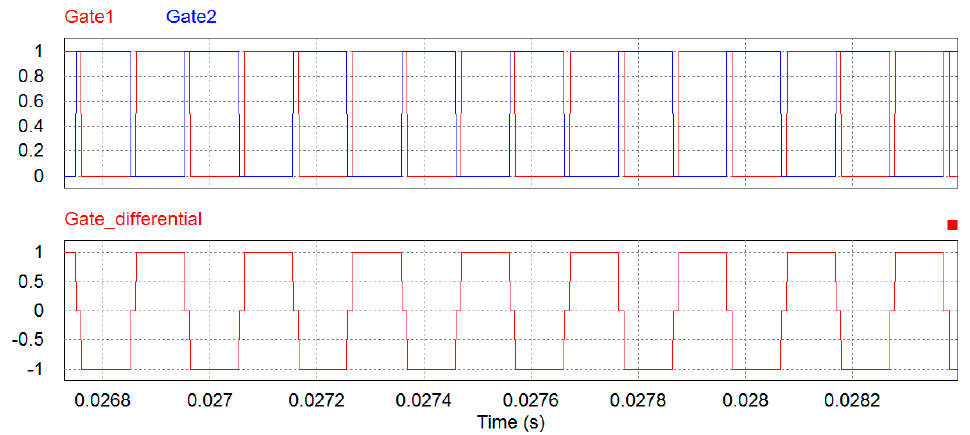
Figure 13. Forty-five percent of the phase error. Two inductor currents (upper) and s 2 * sliding surface (lower).